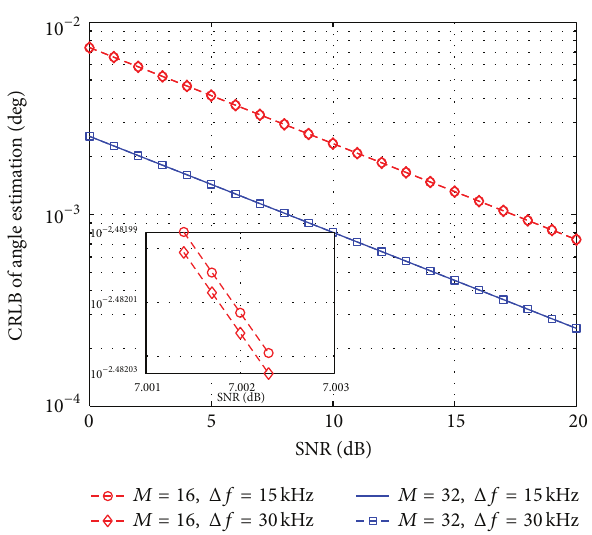
Figure 3: CRLB for estimating range versus SNR when the angle is